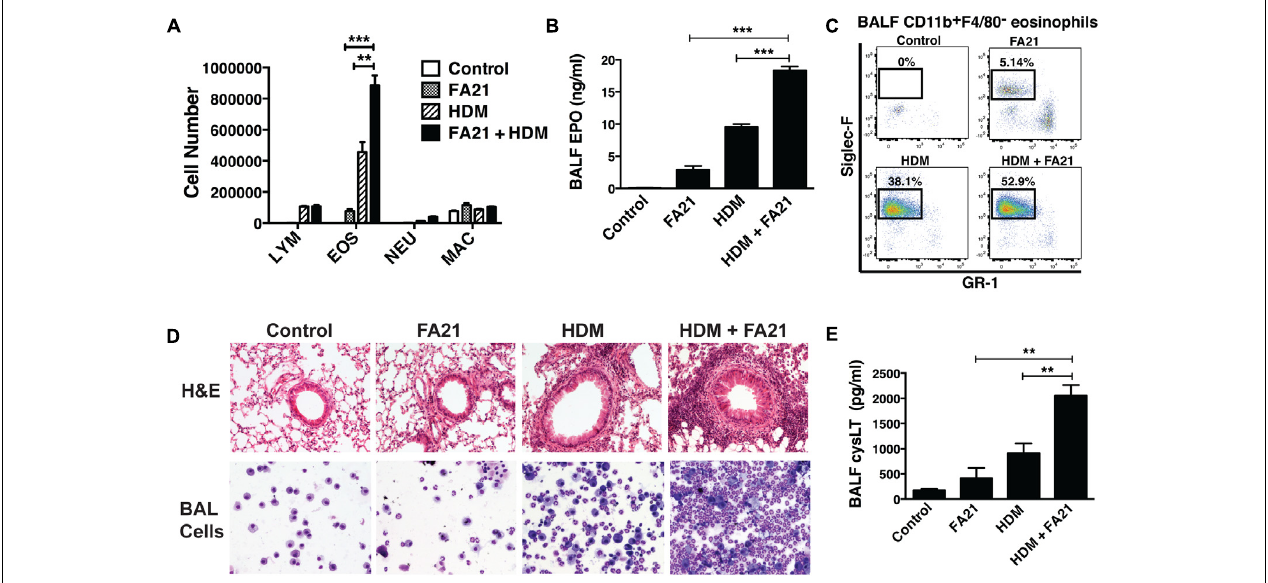
FIGURE 5 | Exposure to FA21 MWCNT exacerbates HDM-induced allergic lung inflammation and promotes cysLT production. To examine the effect of MWCNT exposure on pre-existing allergic airway inflammation, C57BL/6 mice (4–6 per group) were intranasally challenged with PBS (control) or HDM allergen over a 2-week period (on days 0, 7, and 14) to induce allergic inflammation and then exposed to FA21 MWCNT (50 µ g) on day 15 by intratracheal administration. BALF and lung tissue were collected 24 h after MWCNT administration on day 16 for analysis of pulmonary inflammation (as illustrated in the experimental design in Figure 1 ). Groups comprised of mice treated with FA21, HDM, or FA21 + HDM. Control mice were treated with carrier alone. (A) BALF cell differential counts were determined and expressed as absolute cell number per mouse of lymphocytes (LYM), eosinophils (EOS), macrophages (MAC), and polymorphonuclear neutrophils (NEU). (B) Cell-associated EPO levels in the BALF were determined by colorimetric assay. (C) CD11b + F4/80 - GR1 - Siglec-F + eosinophil numbers present in the BALF were analyzed by flow cytometry. (D) Peribronchial and perivascular inflammation was assessed by histological analysis of lung tissue sections stained with H&E (20 × ). In addition, inflammatory cells infiltrating the airways were examined by microscopic evaluation and imaging of cytospin preparations of BALF cells stained using Hema3. (E) CysLT levels present in BALF determined by ELISA. Results are mean ± SEM ( n = 6), ∗∗ p < 0.01 and ∗∗∗ p < 0.001. Data are representative of three independent